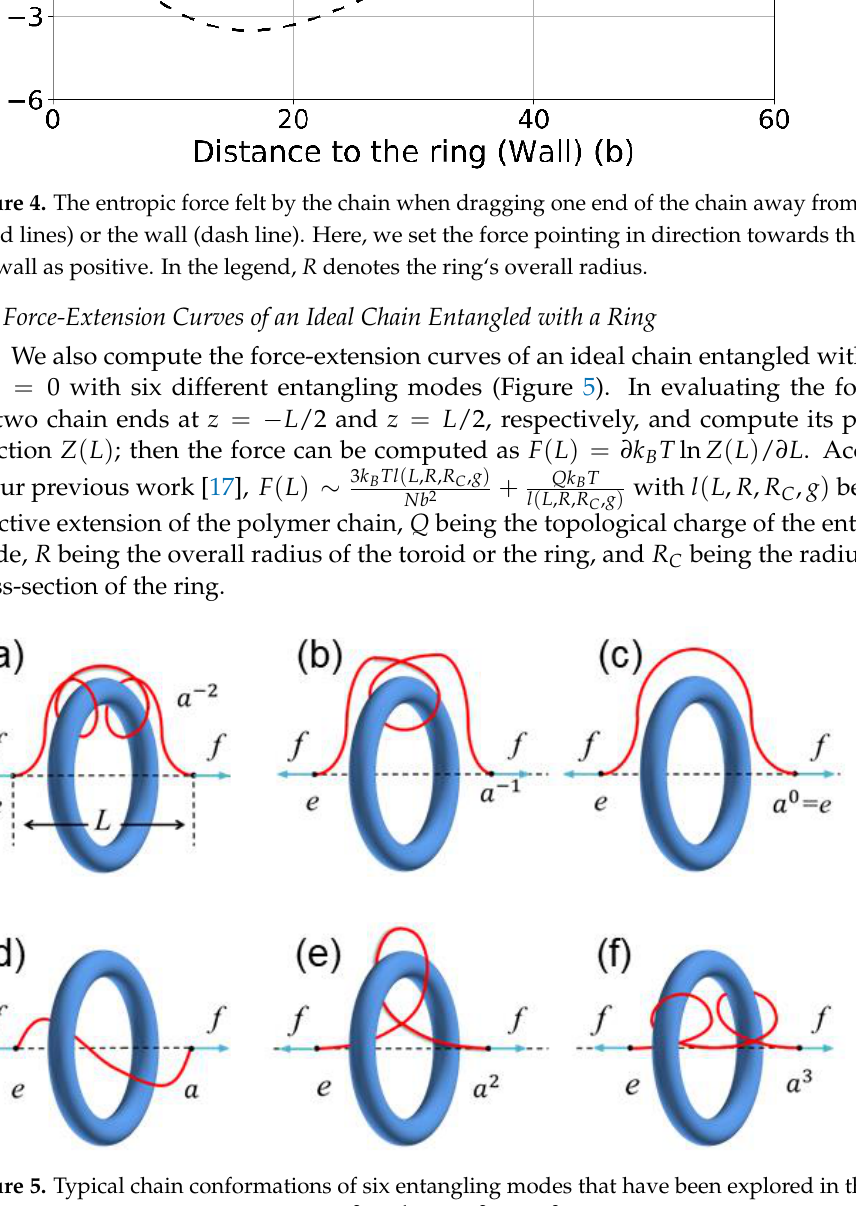
Figure 5. Typical chain conformations of six entangling modes that have been explored in this work. ( a – e ) show the entangling modes of a − 2 , a − 1 , e , a , a 2 and a 3 , respectively; and in each entangling mode, the two ends of the chain with distance separation L are pulled by an external force f